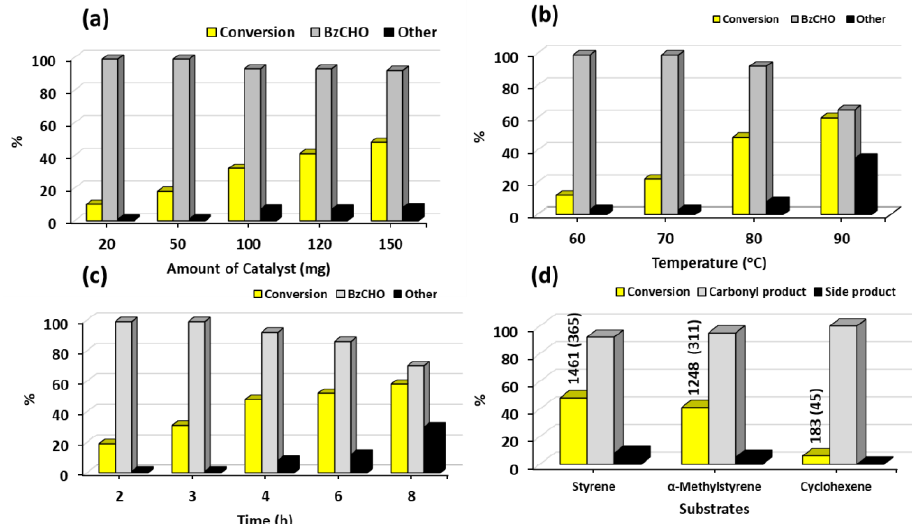
Figure 9. ( a – c ) Optimization of reaction conditions for styrene oxidation. ( d ) Scope and limitations with turn over number (TON, in parenthesis TOF h − 1 ); conversion is based on substrate; substrate (100 mmol); TBHP (0.15 mmol); temperature (80 ◦ C); O 2 balloon 1 atm; amount of catalyst (150 mg); time (4 h)